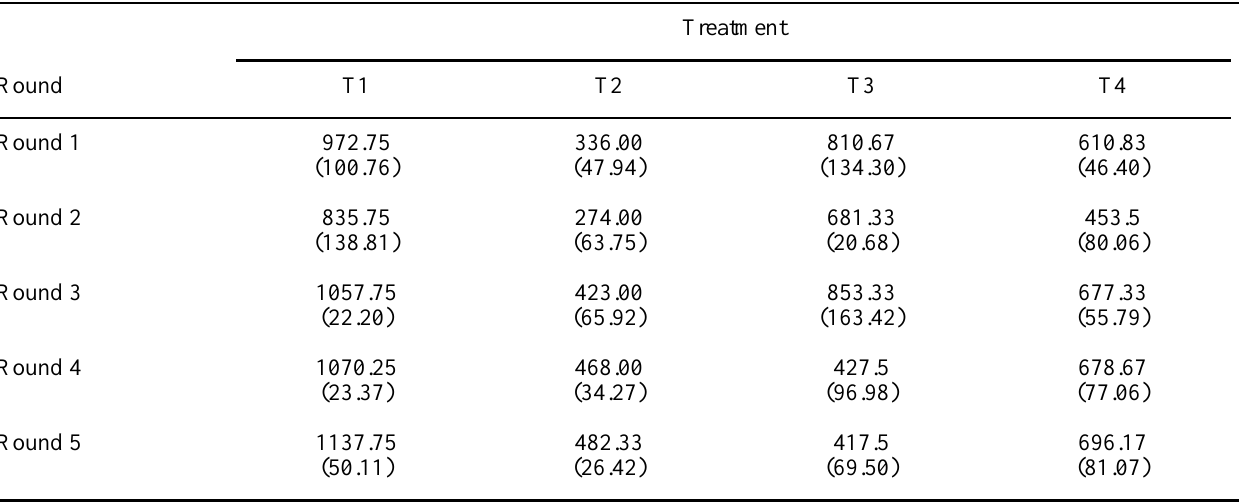
Table 2. Average number of tokens collected at the group level for each round and treatment. The standard deviation is given in